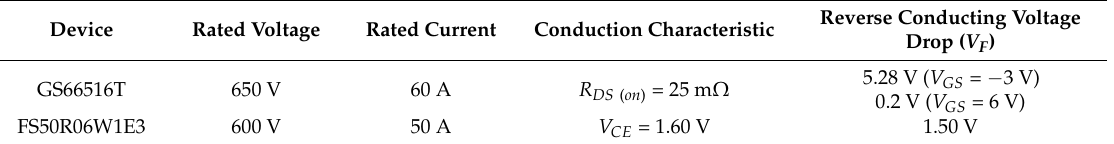
Table 1. Parameters of the two devices.